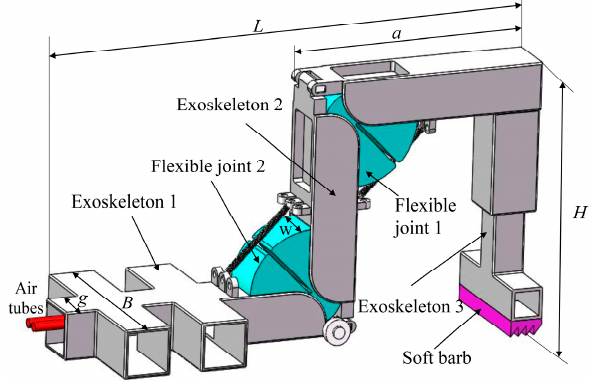
Figure 3. Structure of the soft arthropod robot with two flexible joints.